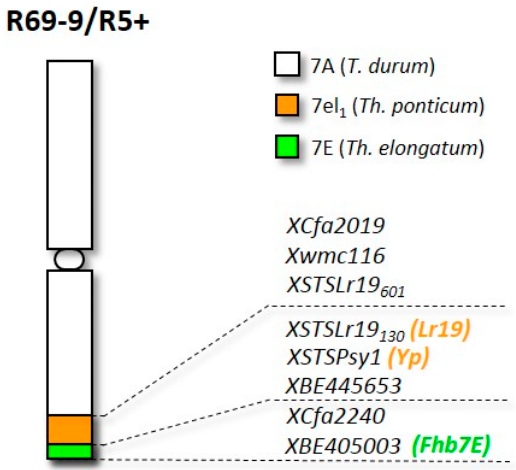
Figure 1. Cytogenetic map of the recombinant 7A-7el 1 /7E chromosome in the FHB-resistant R69-9/R5 HOM+ durum wheat recombinant used in the present study. Disease resistance and yellow pigment genes are indicated in the colour of the Thinopyrum segment of origin.